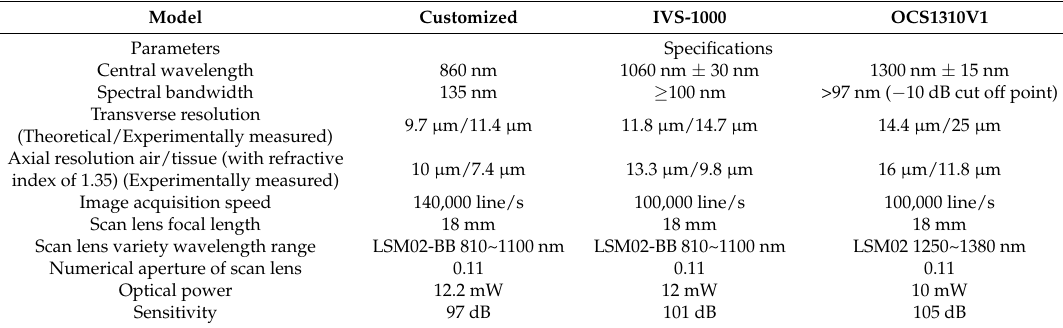
Table 1. Optical specifications of the three OCT systems.